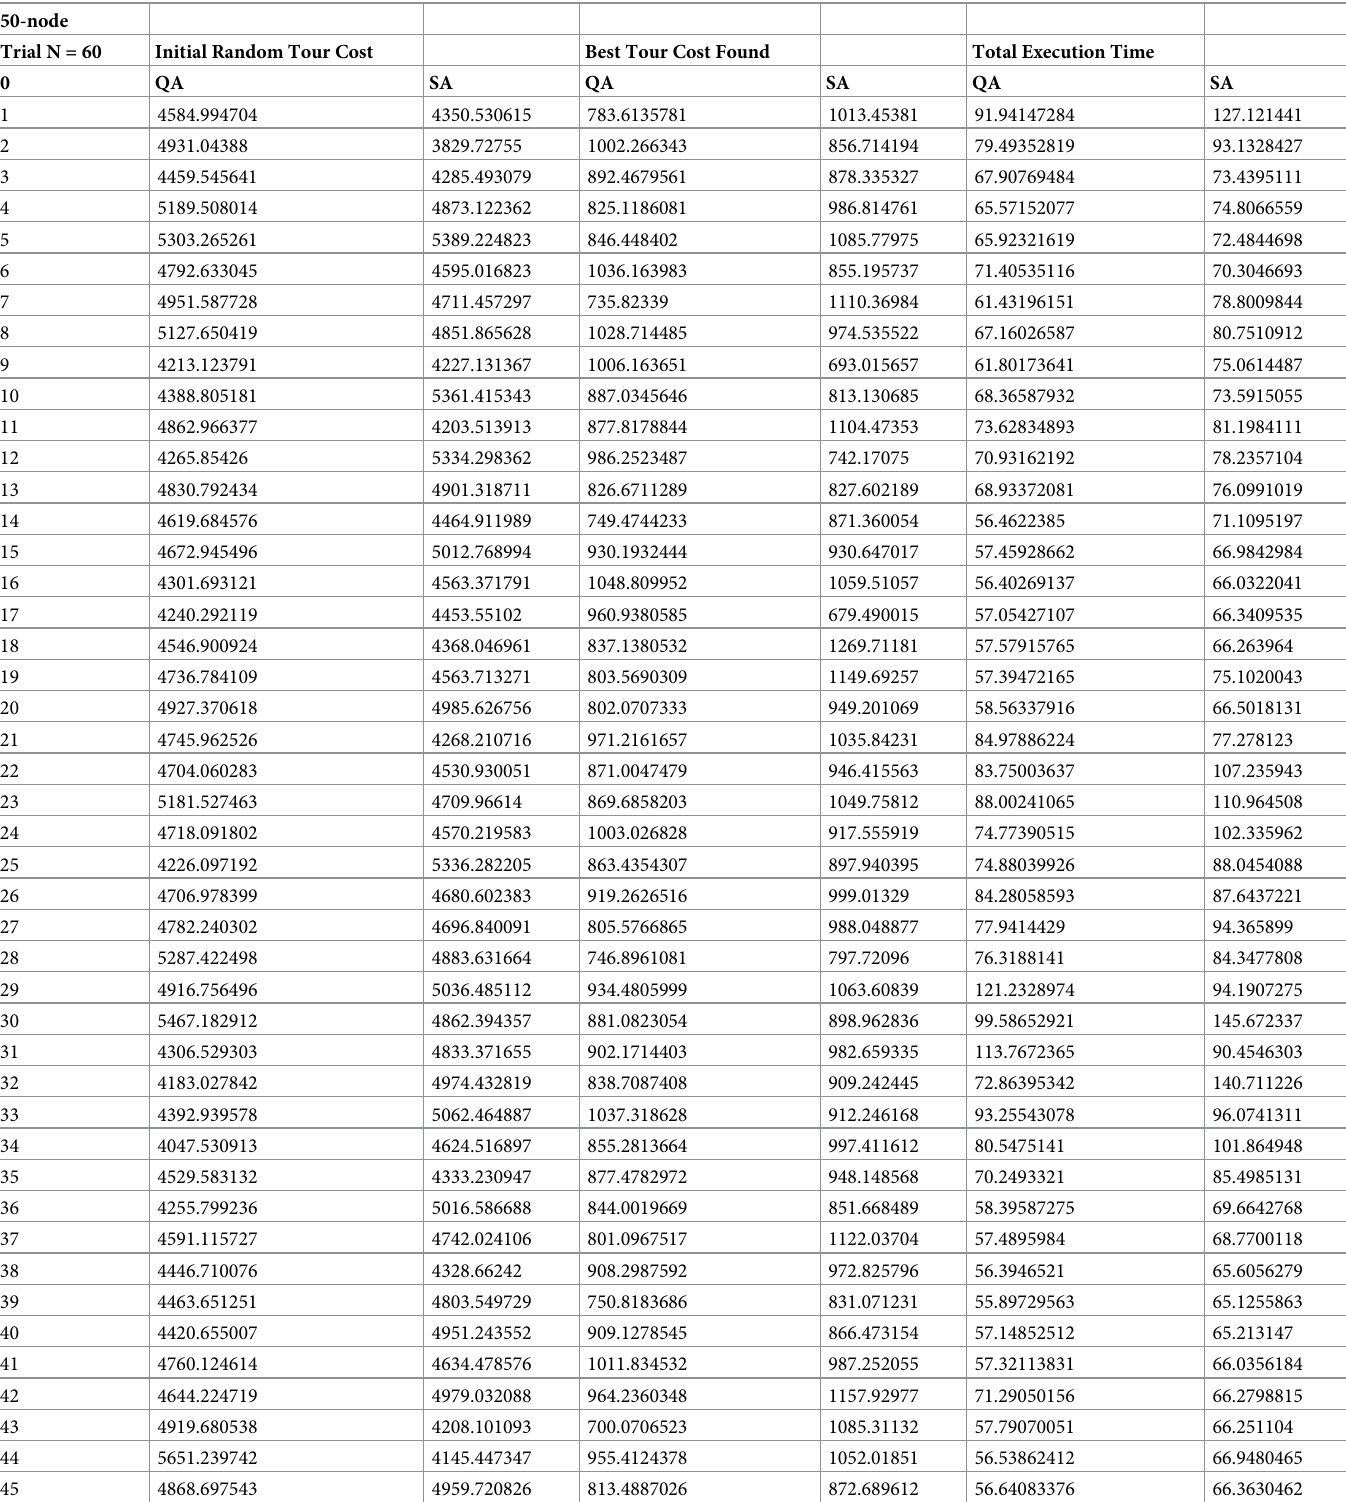
Table 24. Execution results for 50 nodes (n = 50) with samples size N =